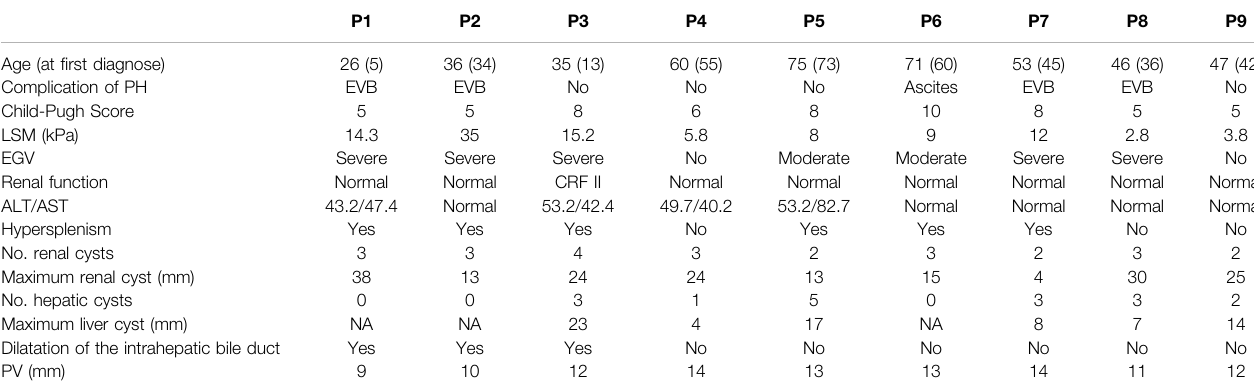
TABLE 2 | The clinical data for nine patients with MRC enrolled for whole-genome sequencing.